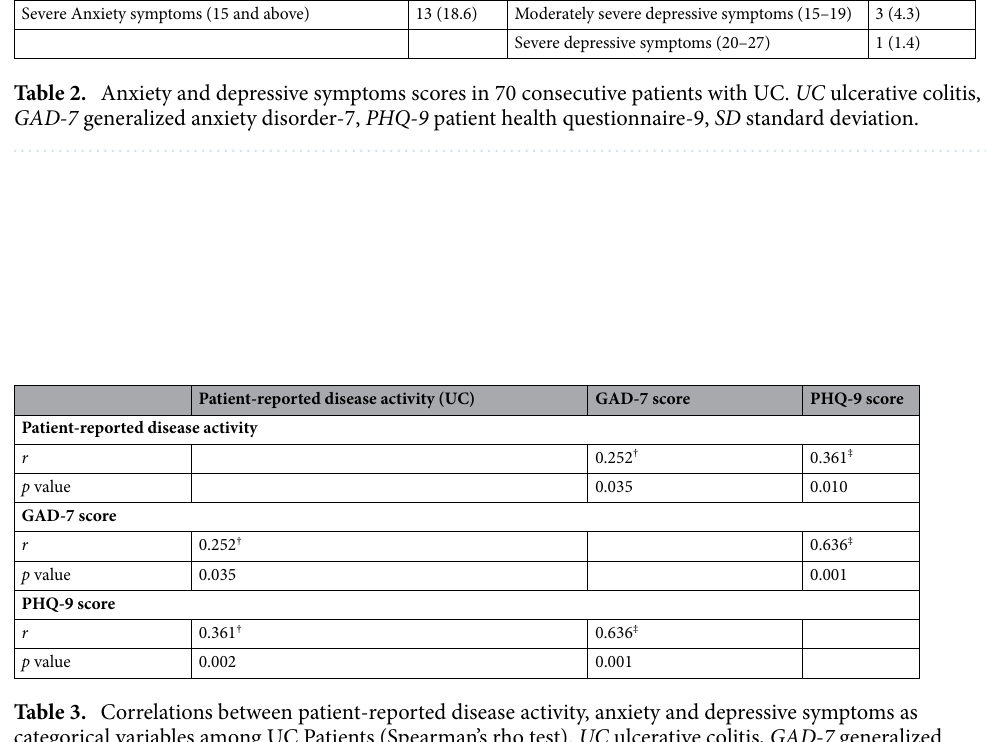
GAD-7 SCORE (Mean ± SD)